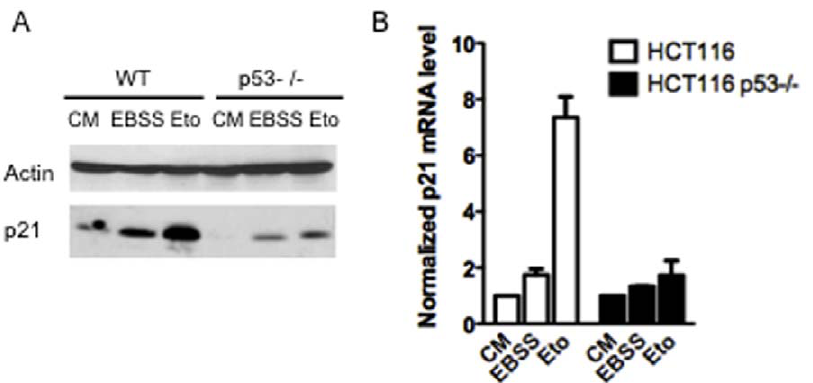
Figure 4. Serum-nutrient starvation enhancement of p21 protein levels. (A) The indicated cells were placed in complete medium (CM), treated 24 h with 50 m M of etoposide (Eto) or starved 24 h in EBSS medium (EBSS). Western analysis was performed to detect p21. (B) The indicated cells were placed in complete medium (CM), treated with 50 m M of etoposide (Eto) or starved in EBSS medium (EBSS) during 6 h for qPCR analysis. p21 mRNA level is expressed as relative values with two house-keeping genes and normalized to complete medium